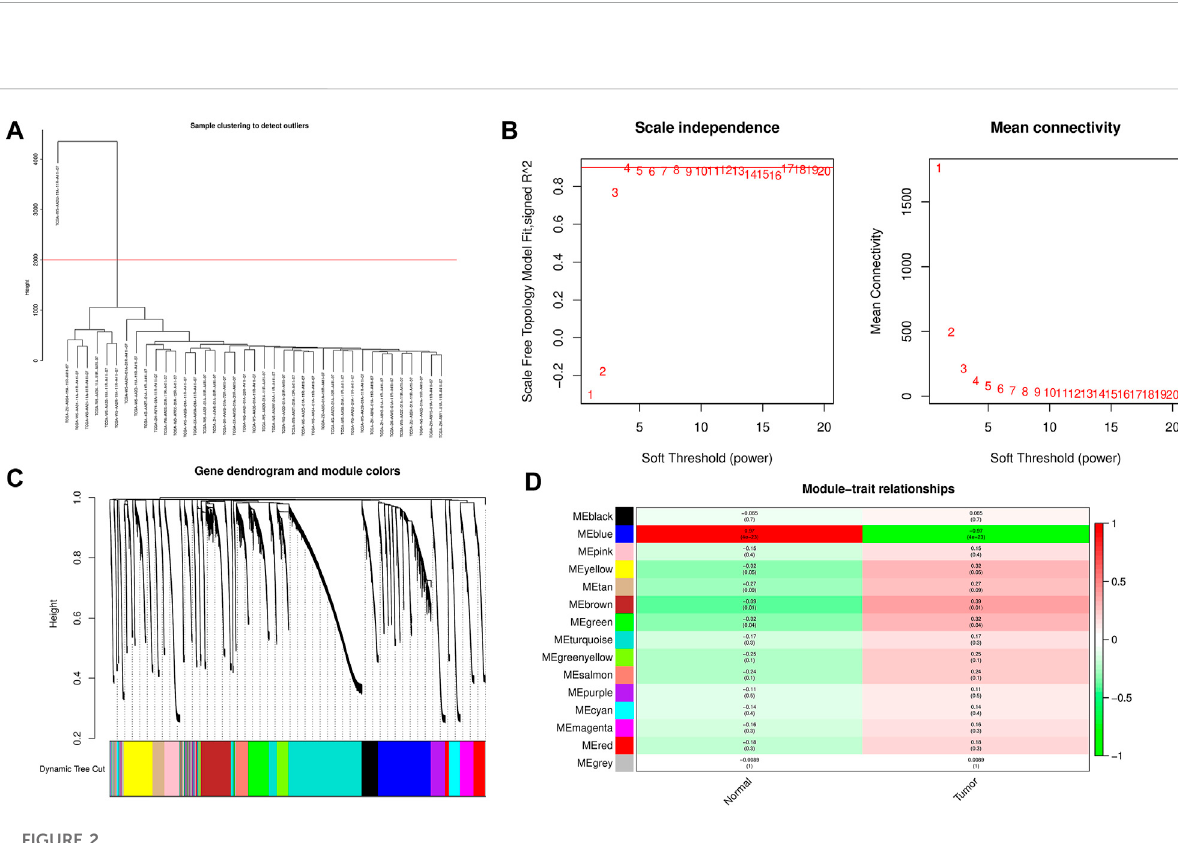
p -values less than 0.05 were de fi ned as statistically signi fi cant.